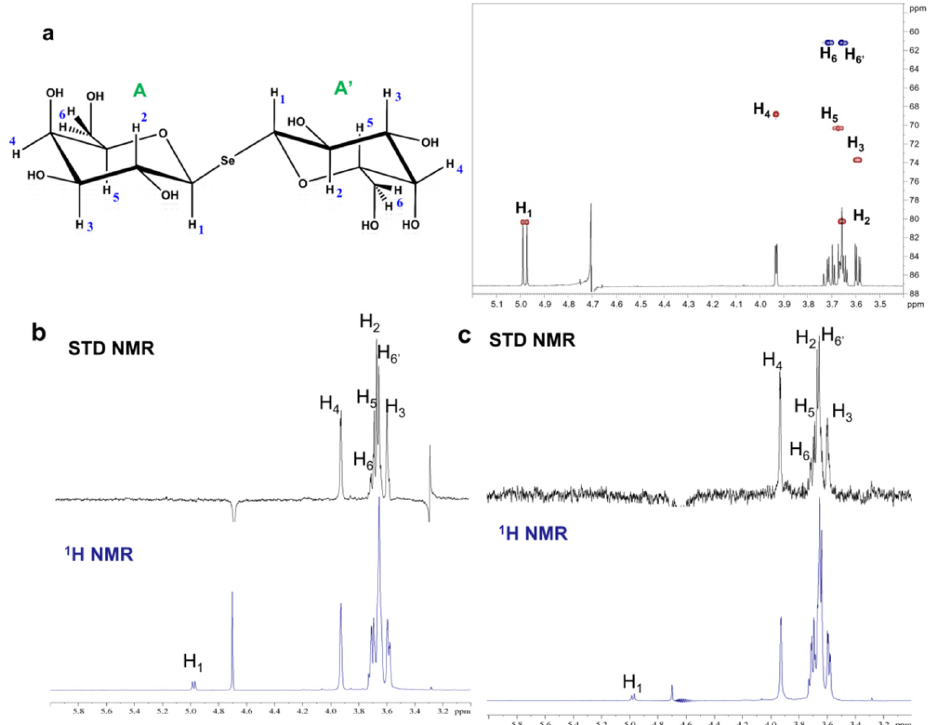
Figure 5. NMR analysis of SeDG with Gal-1 and Gal-3 CRD . ( a ) The SeDG ligand chemical structure is colored according to the symbol-nomenclature for glycans (SNFG) and the HSQC NMR spectrum of the symmetric selenoglycoside with the resonances’ assignment. The galactose residues are named as A and A’. ( b ) 1 H NMR reference spectrum (bottom) and 1D STD NMR spectrum (up) of the 1:40 mixture of Gal-3 CRD : SeDG. ( c ) 1 H NMR reference spectrum (bottom) and 1D STD NMR spectrum (up) of the 1:30 mixture of Gal-1: SeDG.